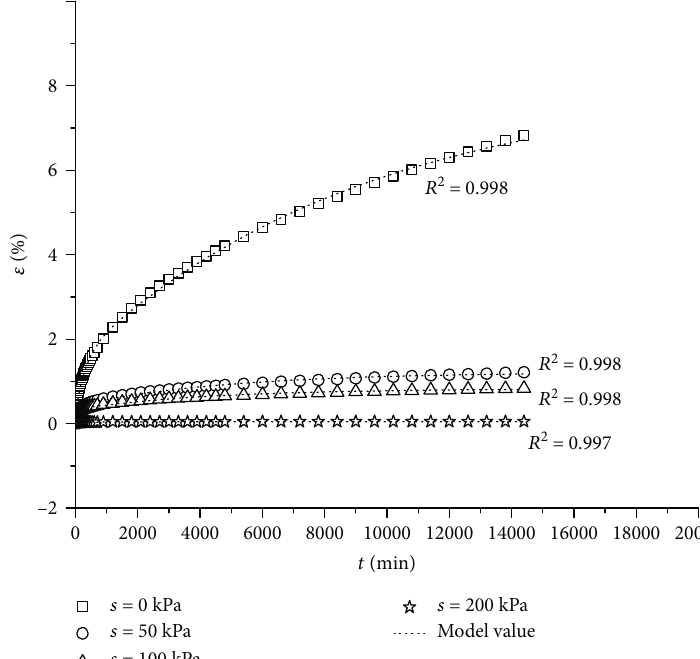
Figure 4: The curve ε − t of di ff erent matric suctions when p = 100 kPa .